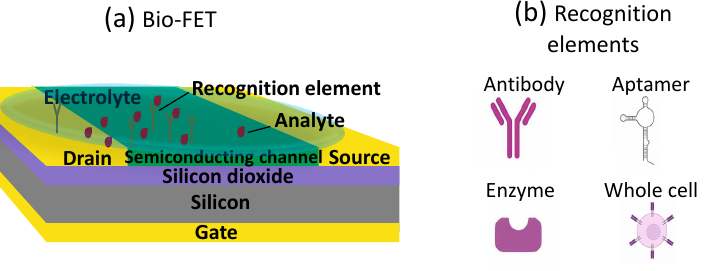
Figure 3. ( a ) General configuration of a bio-FET: the semiconducting channel is functionalized with a recognition element that binds to its specific analyte. In this example, the analyte of interest is present in a liquid solution; the recognition element is drawn in a Y shape typical of antibodies, which are just one example of recognition elements. ( b ) Four examples of the most used recognition elements, which are antibodies (immunological proteins), aptamers (single or double stranded DNA or RNA), enzymes (biological proteins), and whole cells. Image re-adapted from [134] (part ( b